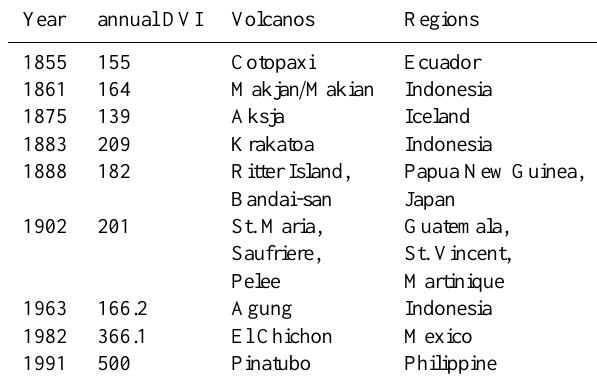
Table 2. Major volcanic eruptions from 1850 to 2000. DVI values taken from the NCDC